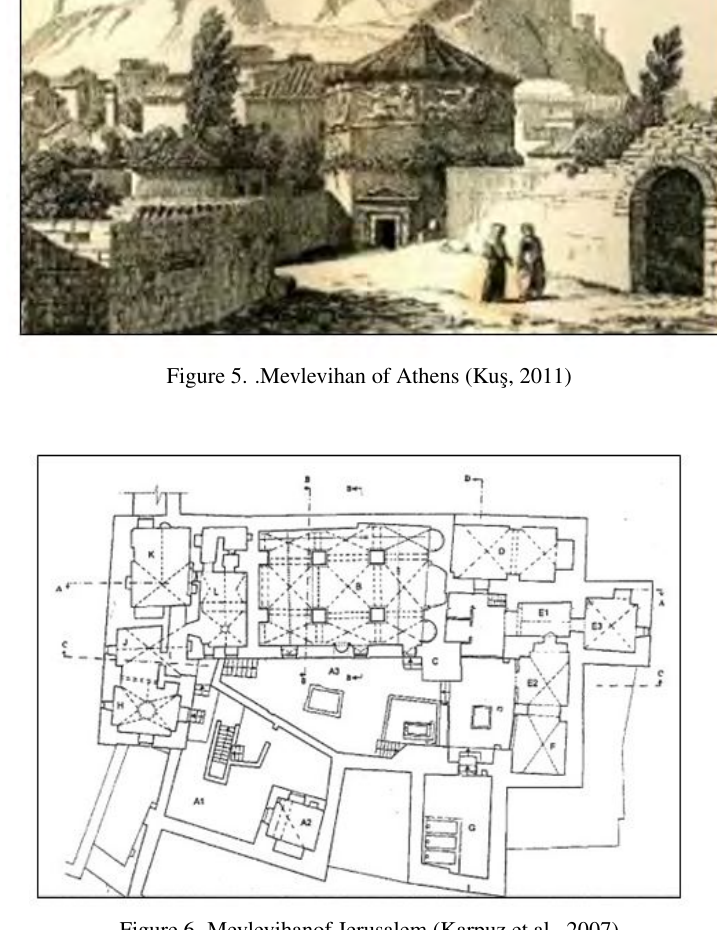
Figure 6. Mevlevihanof Jerusalem (Karpuz et al.,